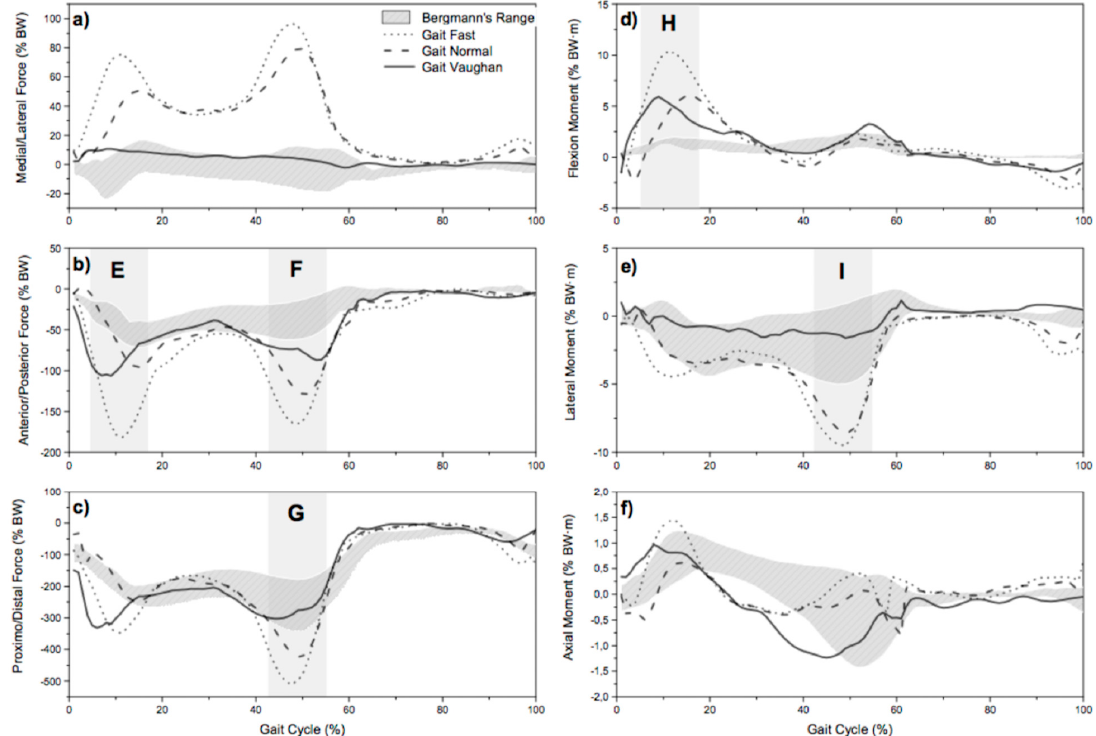
Figure 1. Comparison between in silico: medial / lateral force ( a ), anterior / posterior force ( b ), proximal / distal force ( c ), flexion moment ( d ), lateral moment ( e ), and axial moment ( f ) from three gait types and the in vivo values obtained by Bergman [14].